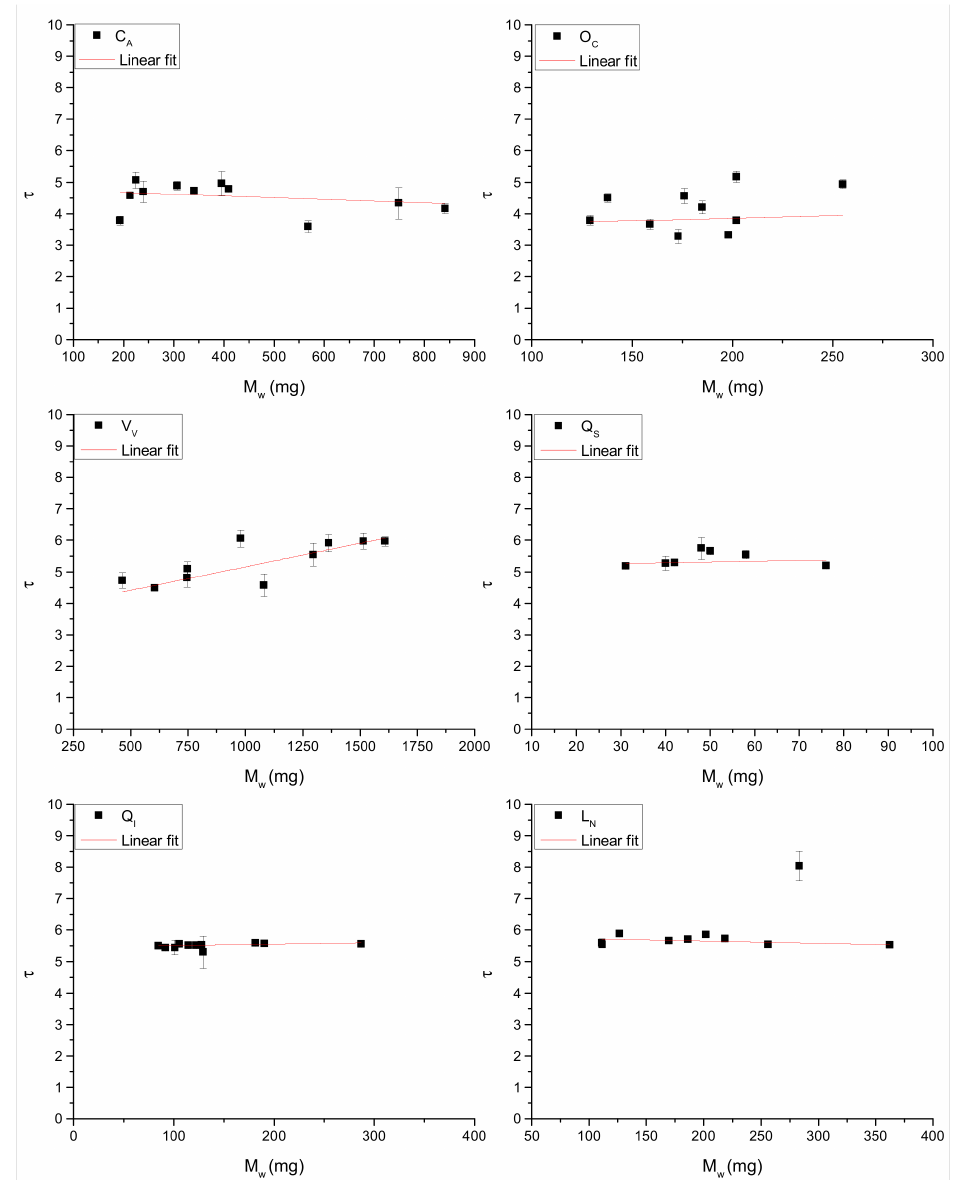
Figure 3. Relationships between τ and M W in the investigated